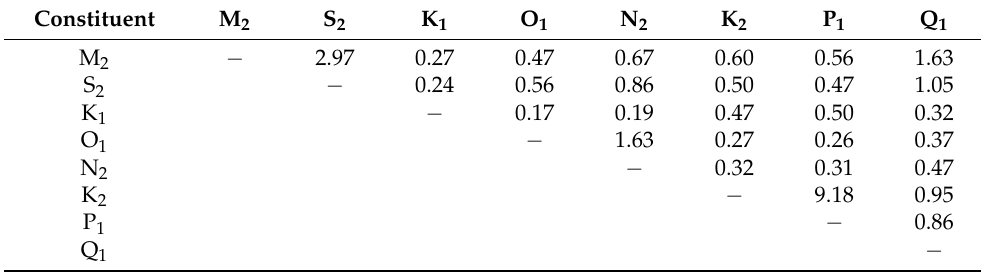
Table 2. Time spans for 8 major tidal constituents to be fully separated (unit: year).